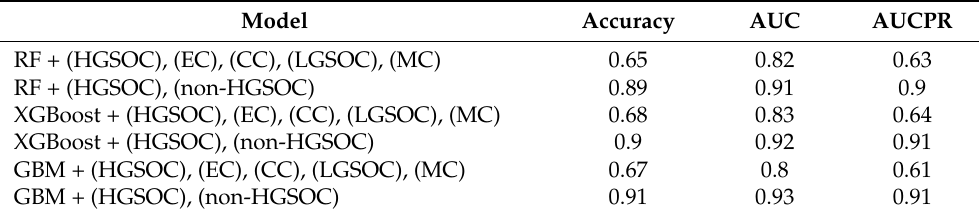
Table 3. Performance metrics of the highest-accuracy machine learning models.